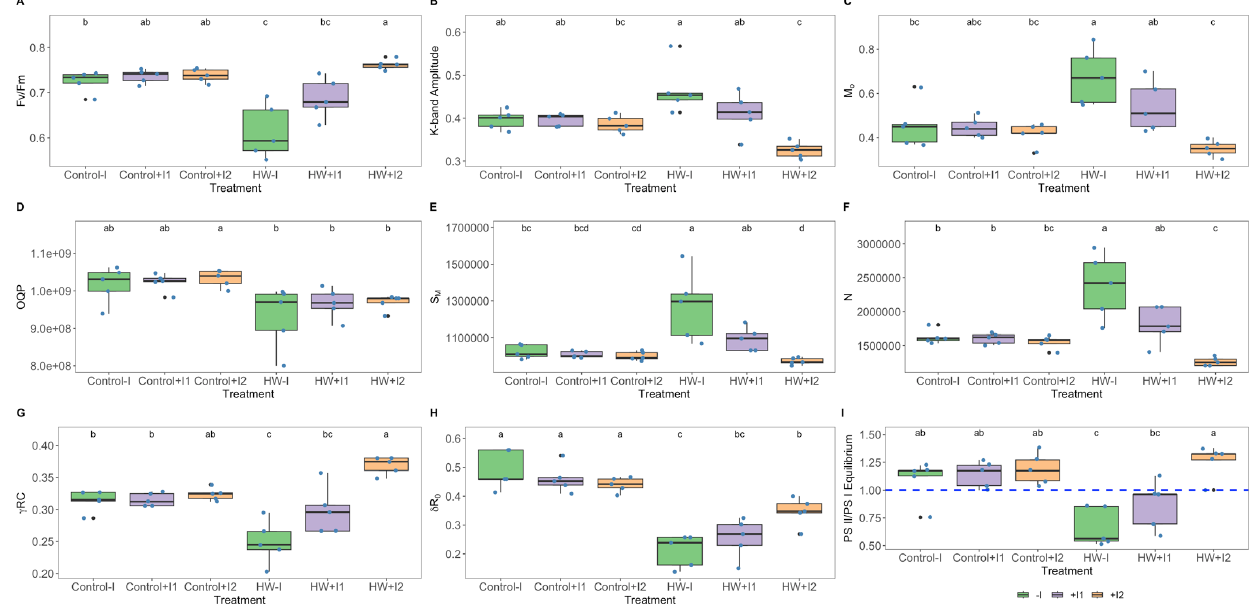
Figure 5. OJIP derived parameters: ( A ) PSII quantum yield (F v /F m ), ( B ) K-band amplitude, ( C ) net rate of PS II reaction centre closure (M 0 ), ( D ) size of the oxidized quinone pool (QOP), ( E ) the energy needed to close all reaction centres (S M ), ( F ) total number of electrons transferred into the electron transport chain (N), ( G ) the probability that a PSII chlorophyll molecule functions as an RC ( γ RC), ( H ) PS I efficiency in reducing its electron acceptors (δ R 0 ), ( I ) PS II/PS I Equilibrium in non-inoculated ( − I) and marine PGPR consortia 1- and 2-inoculated (+I) Vitis vinifera dark-adapted leaves, under normal (control) thermal regimes and exposed to the heatwave (HW) (average ± standard deviation, N = 5, letter denotes significant differences at p < 0.05).